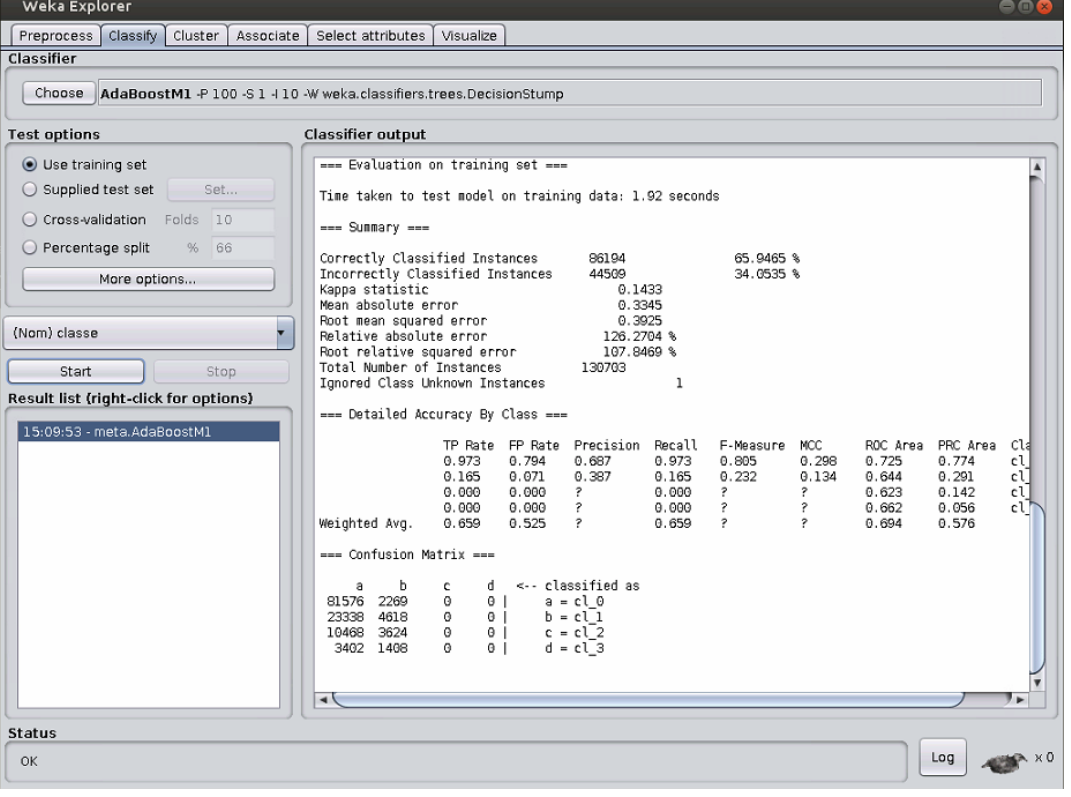
Figure 1. An example of a classification error when the classes are